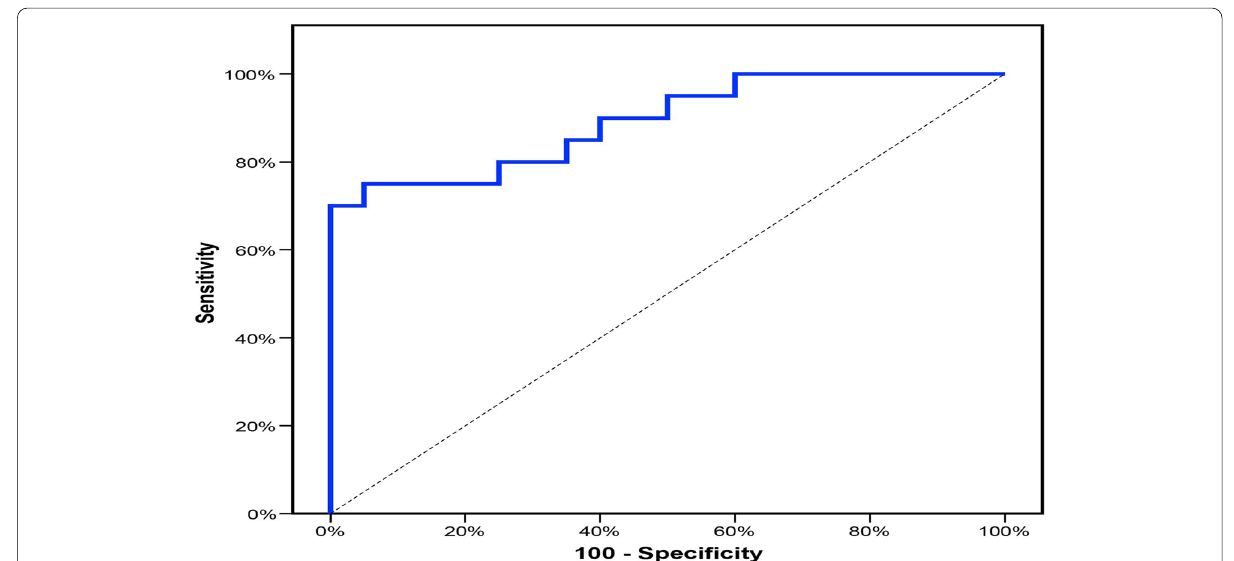
Fig. 6 ROC curve for serum YKL‑40to discriminate group III ( n